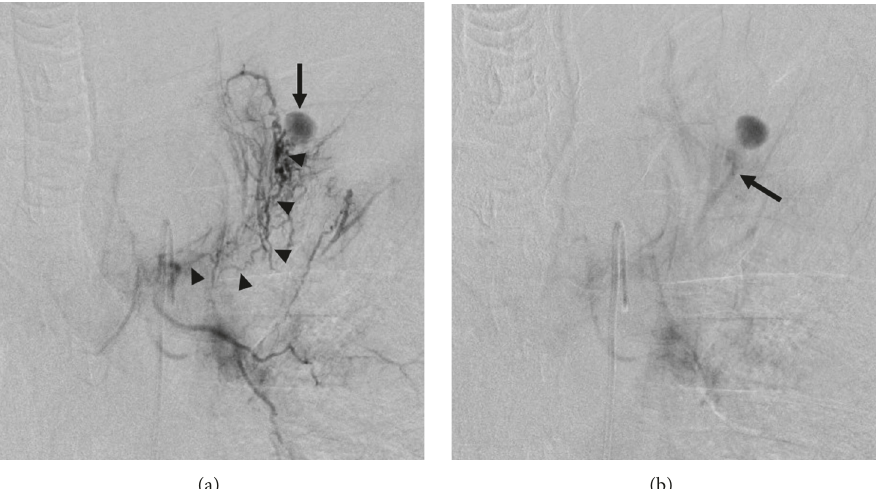
Figure 3: Bronchial angiography. (a) The early phase depicts the aneurysm (arrow) via small and tortuous anastomoses (arrowheads) from the left bronchial artery. (b) The delayed phase shows the parent pulmonary artery of the aneurysm (arrow) via a shunt from the left bronchial artery.